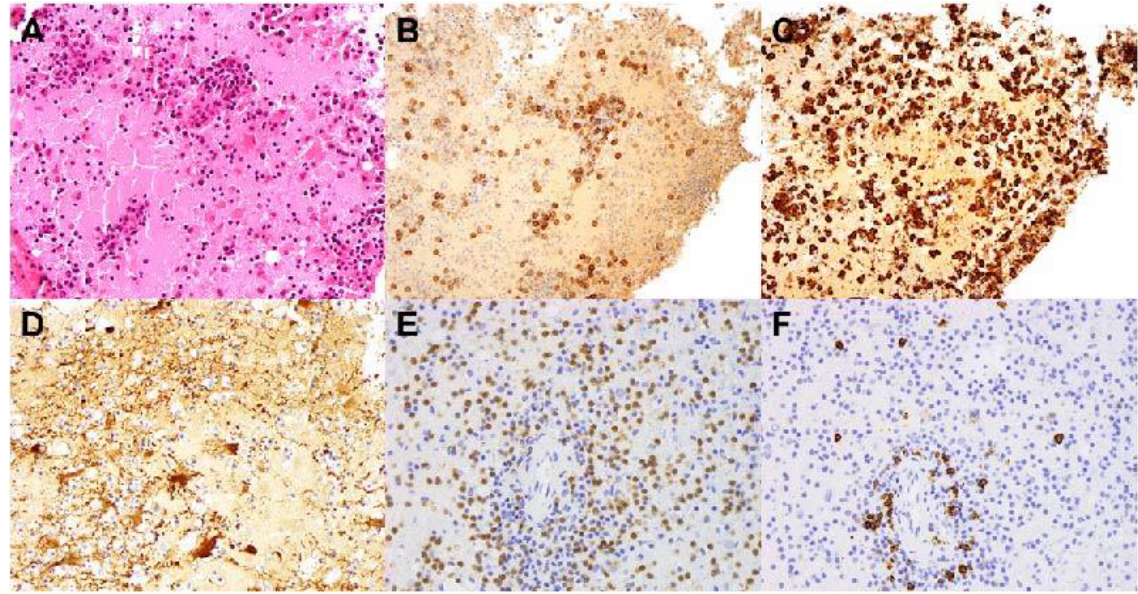
Figure 3. Stereotactic brain biopsy of the subcortical white matter. ( A ) Haematoxylin and eosin (H&E) stained sections show white matter oedema, perivascular and parenchymal inflammation and reactive gliosis. ( B ) CD138 immunohistochemistry highlights numerous plasma cells, and ( C ) CD163 demonstrates an abundance of macrophages/microglia. ( D ) GFAP immunohistochemistry demonstrates reactive astrocytes with unusual granularity of their processes. ( E ) Numerous CD3-positive T cells are present. ( F ) low numbers of CD20 positive B cells. (Magnification 200× A – D; 400× E,F).